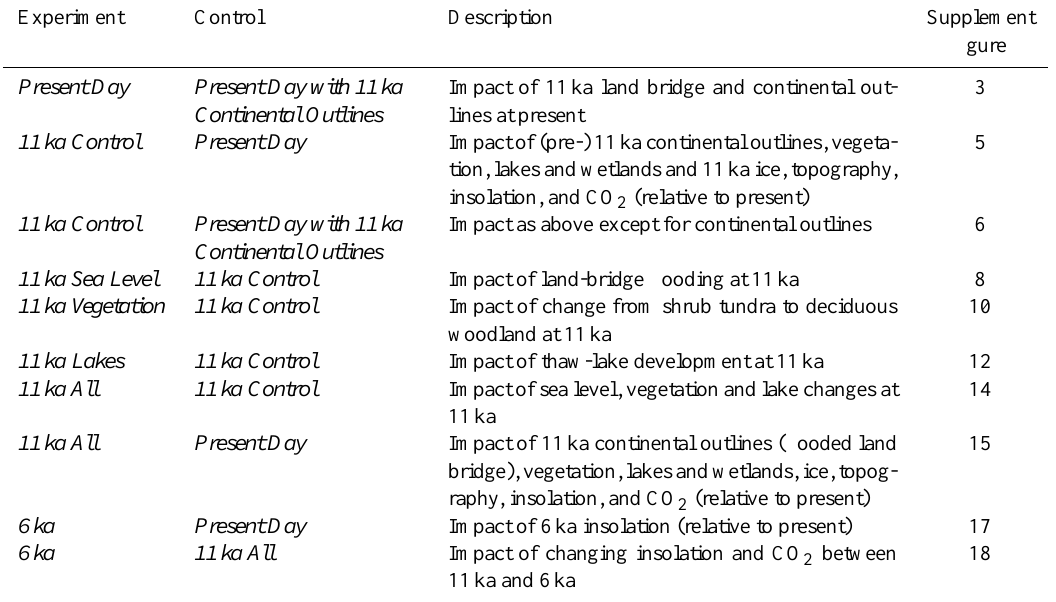
Table 2. Experiments.